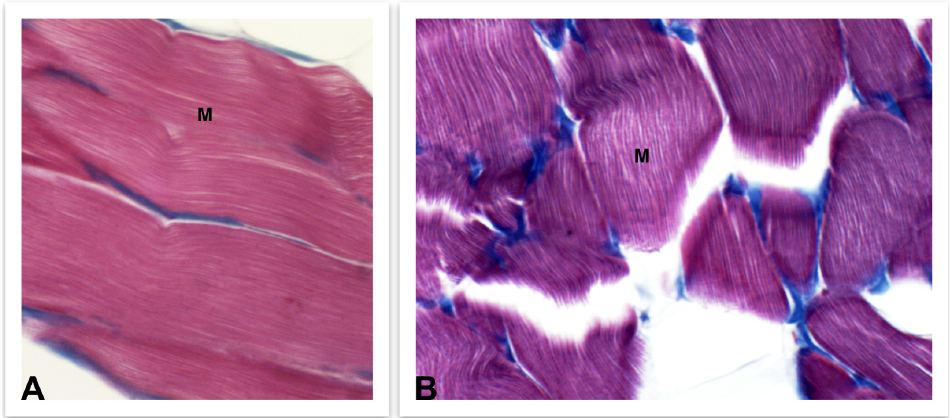
Figure 4. Light micrographs of the skeletal muscle of Anguilla anguilla . Mallory staining. ( A ) Control and ( B ) exposed specimens. In exposed specimens, the muscle fibres (M) showed less compactness and numerous breaks. Magnification: 400 ×